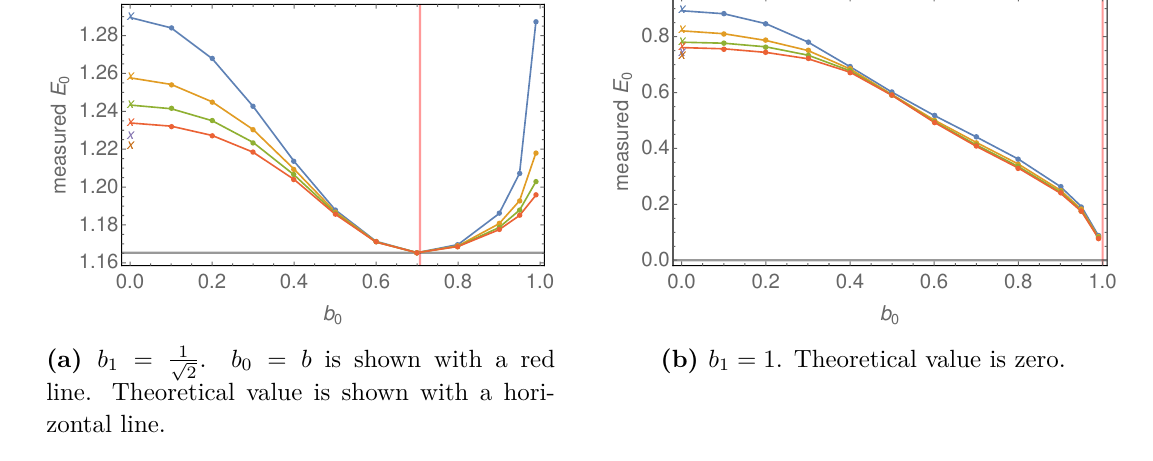
Figure 23. Cutoff dependence of ground state energy at coupling b 1 , volume R = 6 , starting from different b 0 couplings. Blue, orange, green, red, purple and brown symbols correspond to cutoffs N max = 2 , 4 , 6 , 8 , 10 , 12 , respectively. Results from the free massive boson basis ( b 0 = 0 ) are distinguished with x-marks. µ 0 = 1 , µ 1 = 1 2 b 2 0 2 b 2 1